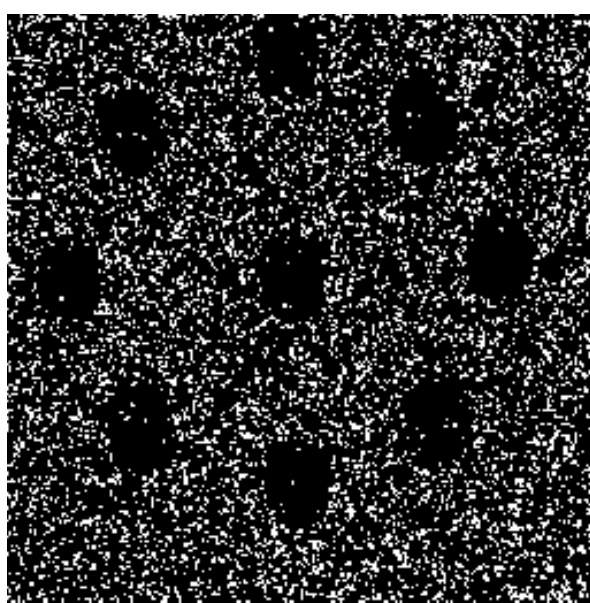
Figure 2. Integrated Timepix3 data over a time of 10ms using a radiation quality of H-60 (ISO, 2019) and under a gradient angle of 15 ◦ . A typical frame like this consists of roughly 12000 photon events.